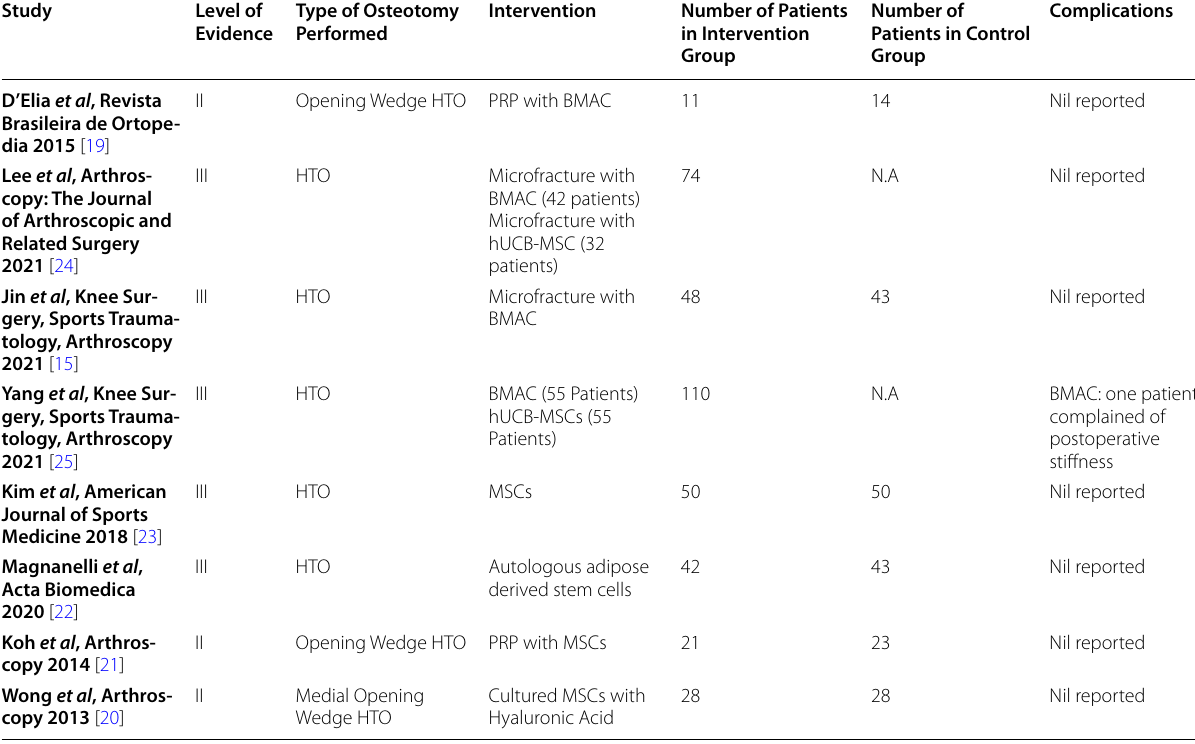
Table 2 Summary of included